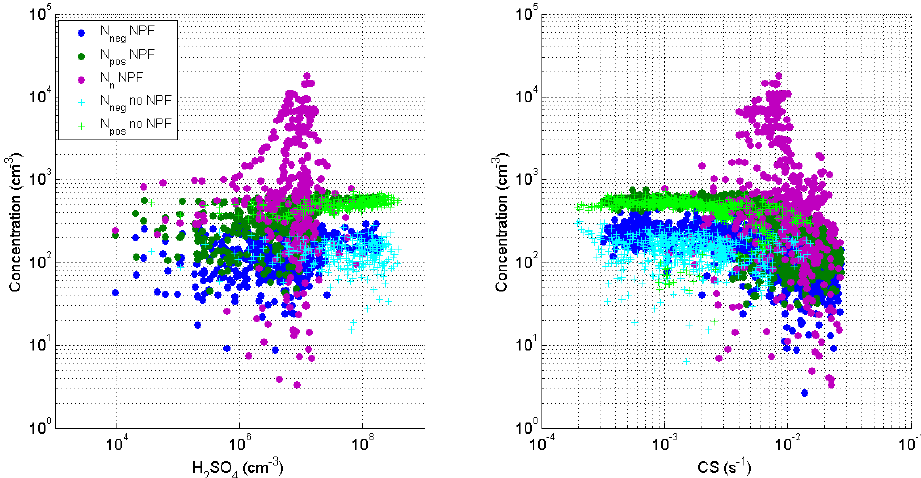
Figure 7. Nanoparticle concentrations as a function of potential nucleation source and sink. Positive ( N pos ) , negative ( N neg ) and neutral cluster ( N n ) concentrations as a function of (a) sulfuric acid concentration and (b) condensation sink are reported separately, for NPF event and non-event days. Neutral cluster concentrations which are negative on non-event days are not shown on the figure. February 2012, Puy de